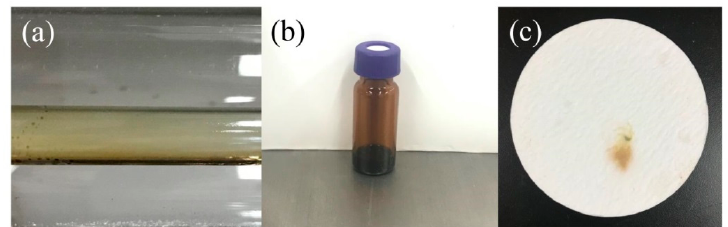
Figure 4. Flavescent oily liquids collected from the inner wall of the quartz tube: ( a ): oily liquids in the quartz tube; ( b ): collected from the quartz tube; ( c ): collected by cambridge pad.